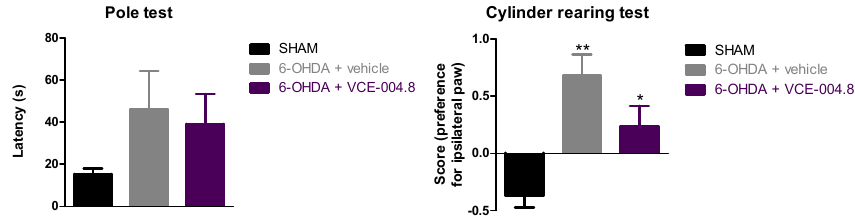
Figure 2. Response in the pole test and in the cylinder rearing test of control (sham) mice and unilaterally 6-OHDA-lesioned animals treated with VCE-004.8 (20 mg/kg) or vehicle (Maisine CC/corn oil) given orally. Treatments were daily and prolonged for 2 weeks. Data corresponded to 24 h after the last dose and were expressed as means ± SEM of more than 5 animals per group. They were analyzed by one-way ANOVA followed by the Bonferroni test (* p < 0.05, ** p < 0.01 versus sham).